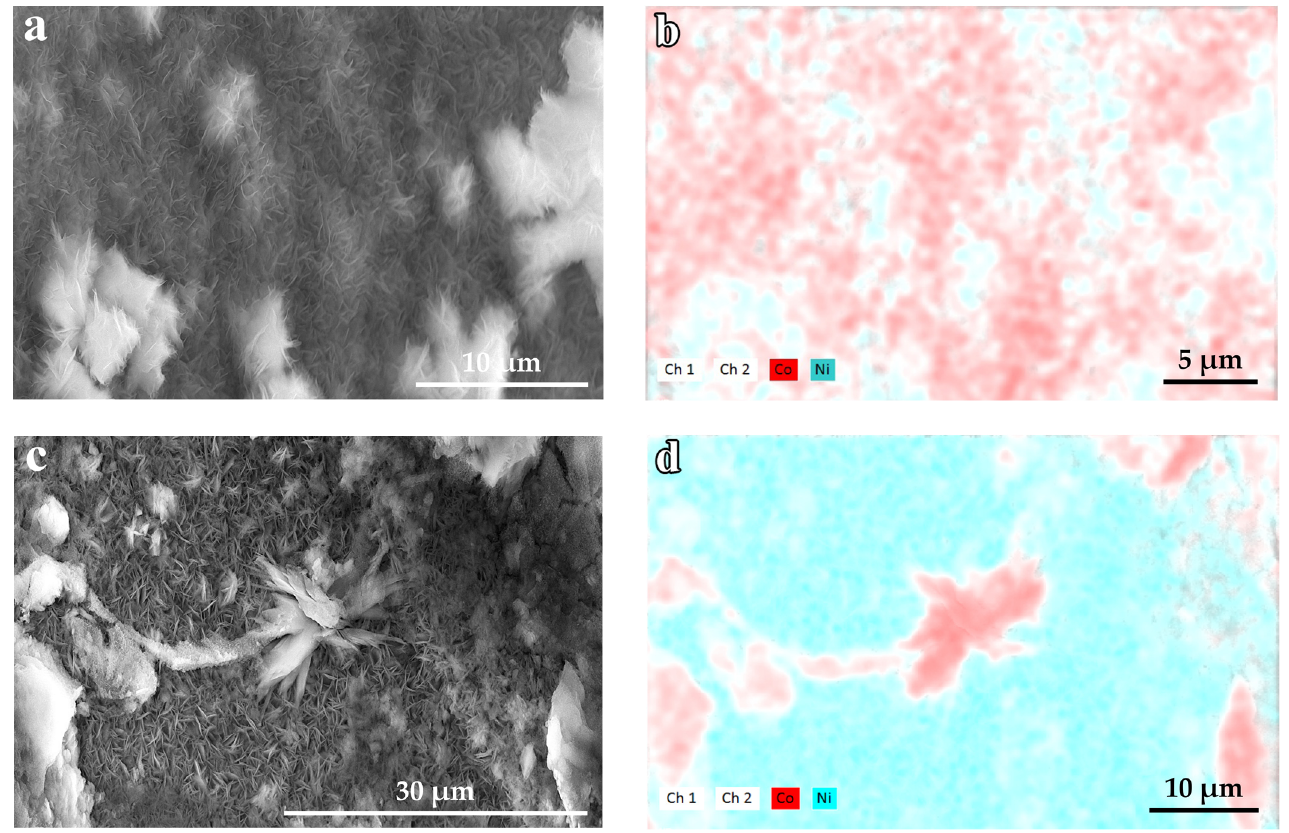
Figure 6. SEM images and the corresponding element distribution of the samples: ( a ), ( b ) Ni(OH) 2 - PVP-Co-elchem; ( c ), ( d ) Ni(OH) 2 -PVP-Co-chem (flower-like crystal in the center).